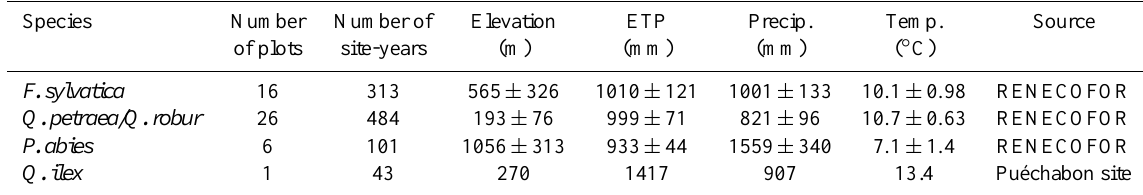
Table 1. Climatic features of the studied sites. ETP is annual Penman–Monteith potential evapotranspiration, Precip. is annual precipitation, and Temp. is annual temperature. Values are site averages ± SD among sites. Species Number Number of Elevation ETP Precip. Temp. Source of plots site-years (m) (mm) (mm) ( ◦ C) 16